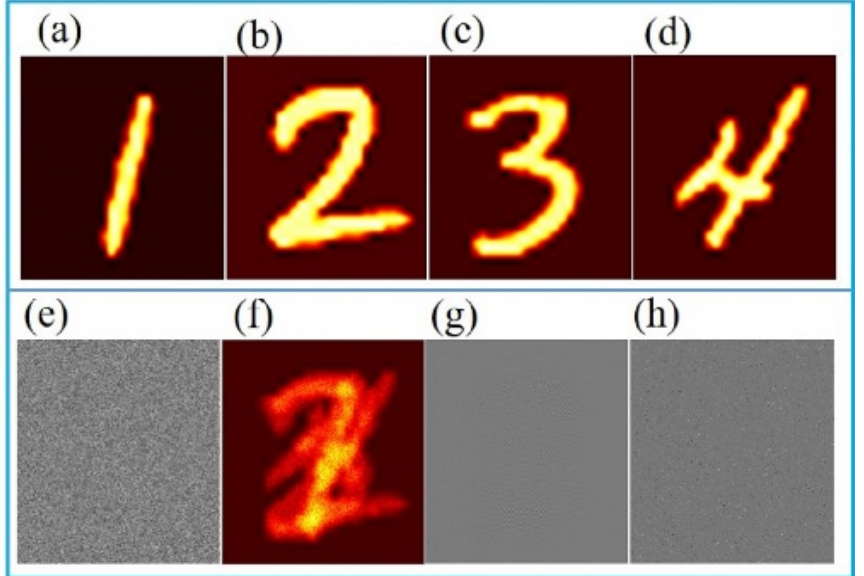
Figure 4. ( a – d ) Four plaintext images in the first group. ( e ) One of the random matrices. ( f ) The group ciphertext. ( g ) After superposition ciphertext. ( h ) After scrambling ciphertext.